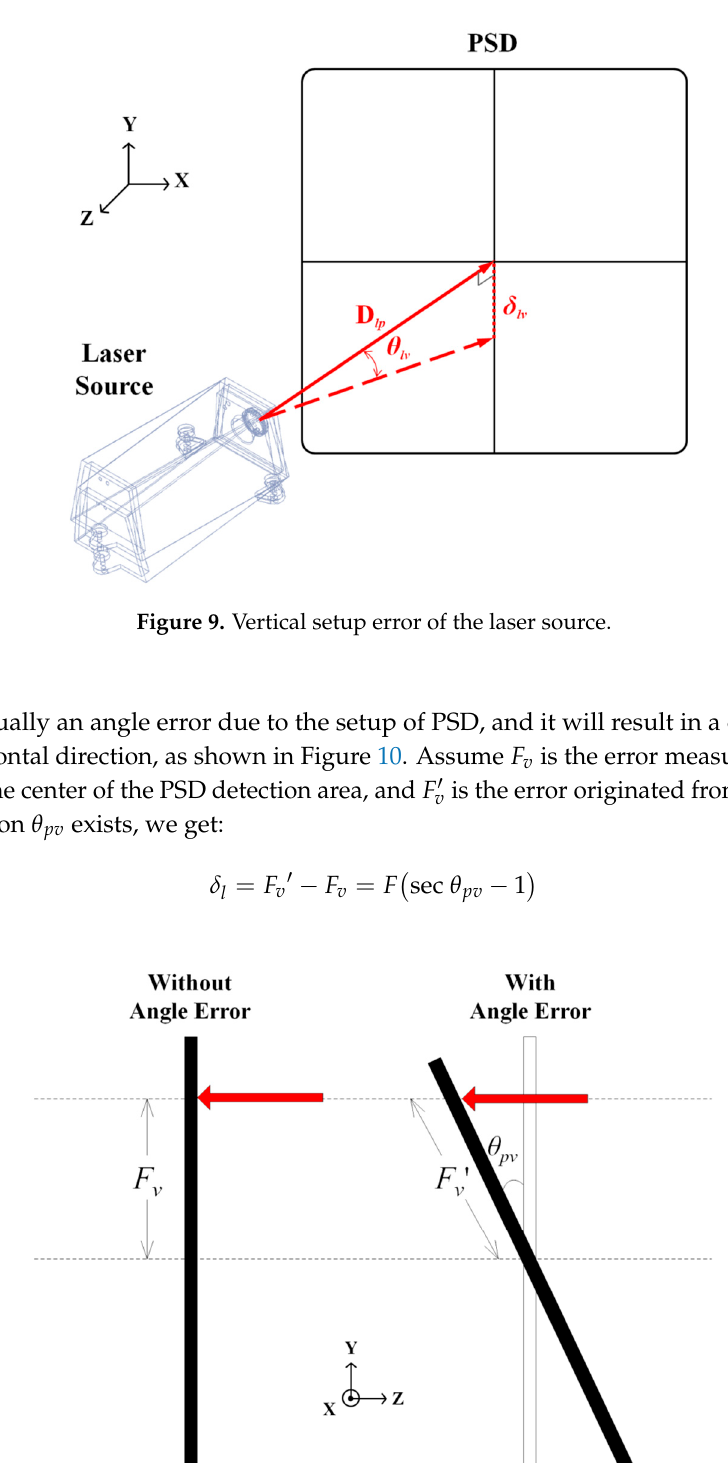
Figure 11. Vertical setup error of the pentaprism.